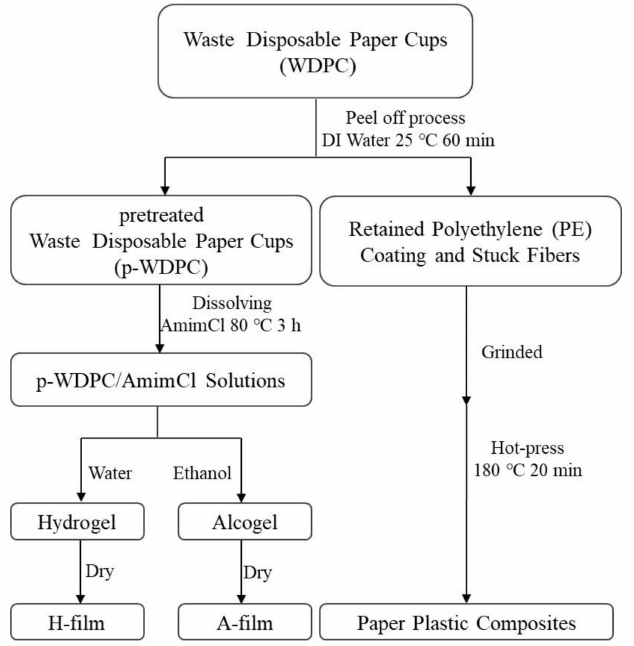
Figure 1. Preparation scheme of cellulose-based films (H-film and A-film) and paper plastic compos- ites from waste disposable paper cups (WDPC).